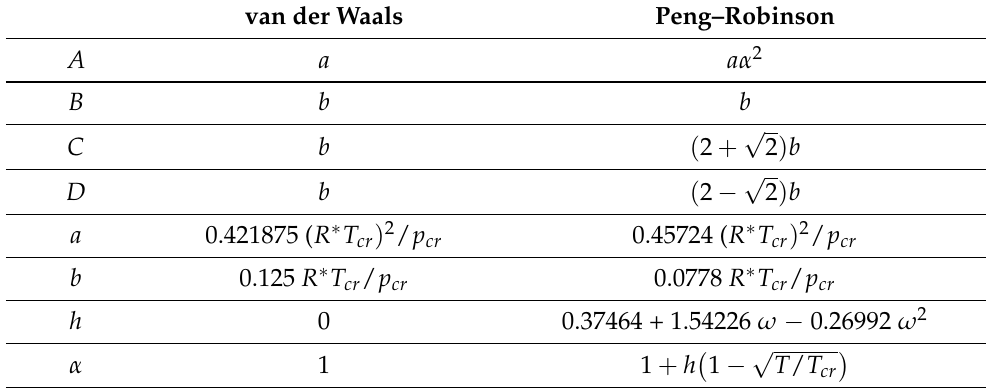
Table 1. Expressions for all the quantities involved in Equation